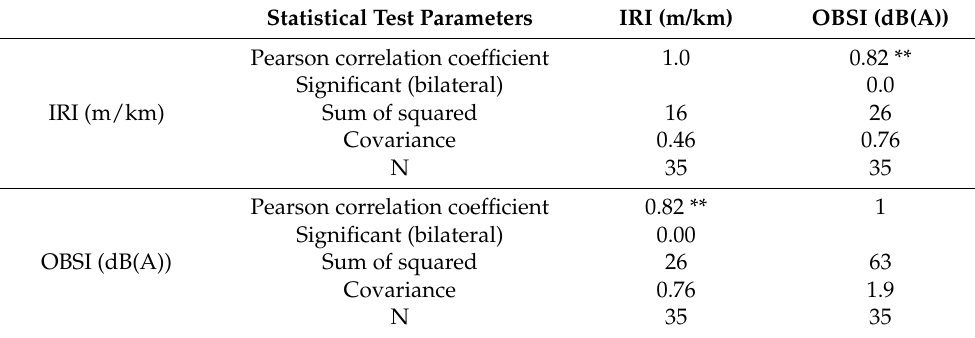
Table 3. Correlation analysis between pavement roughness and tire/pavement